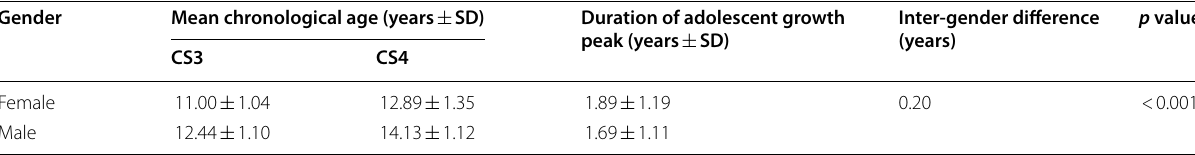
Table 3 Comparison of the mean duration of adolescent growth peak between two genders (independent samples t test) Gender